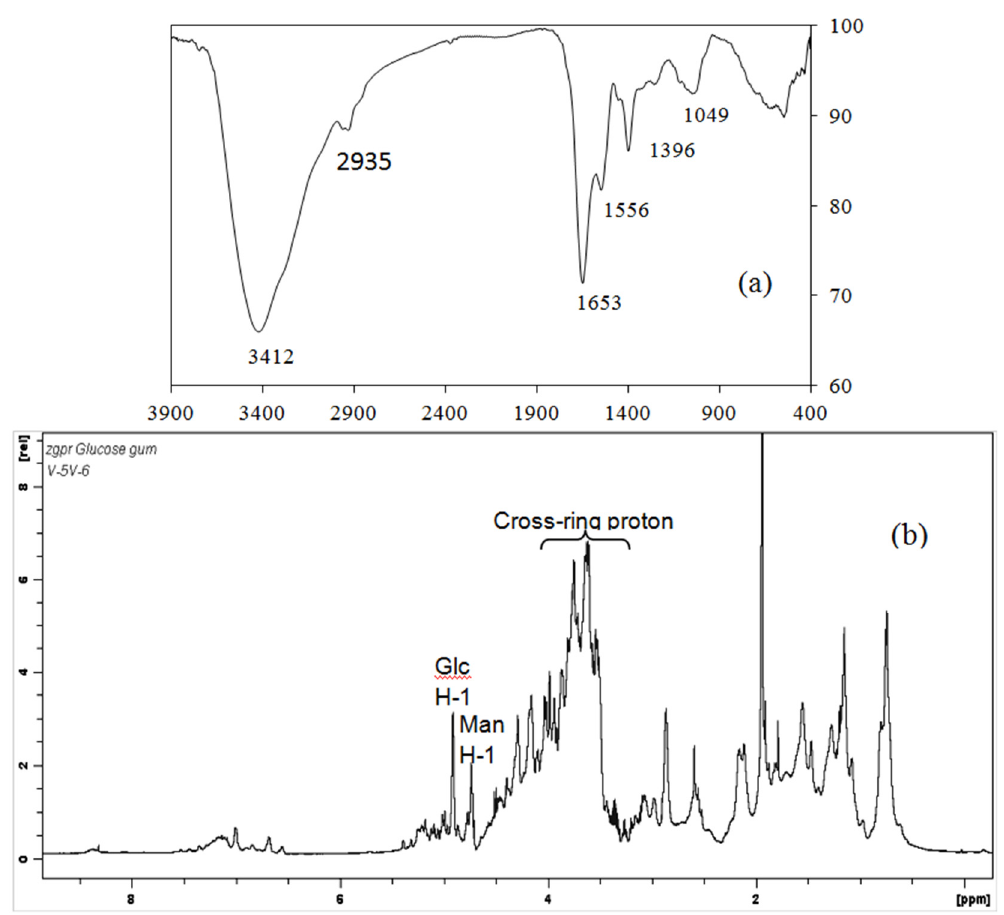
Figure 2. IR and NMR spectra of Cs-GP1: ( a ) IR; ( b ) 1 H